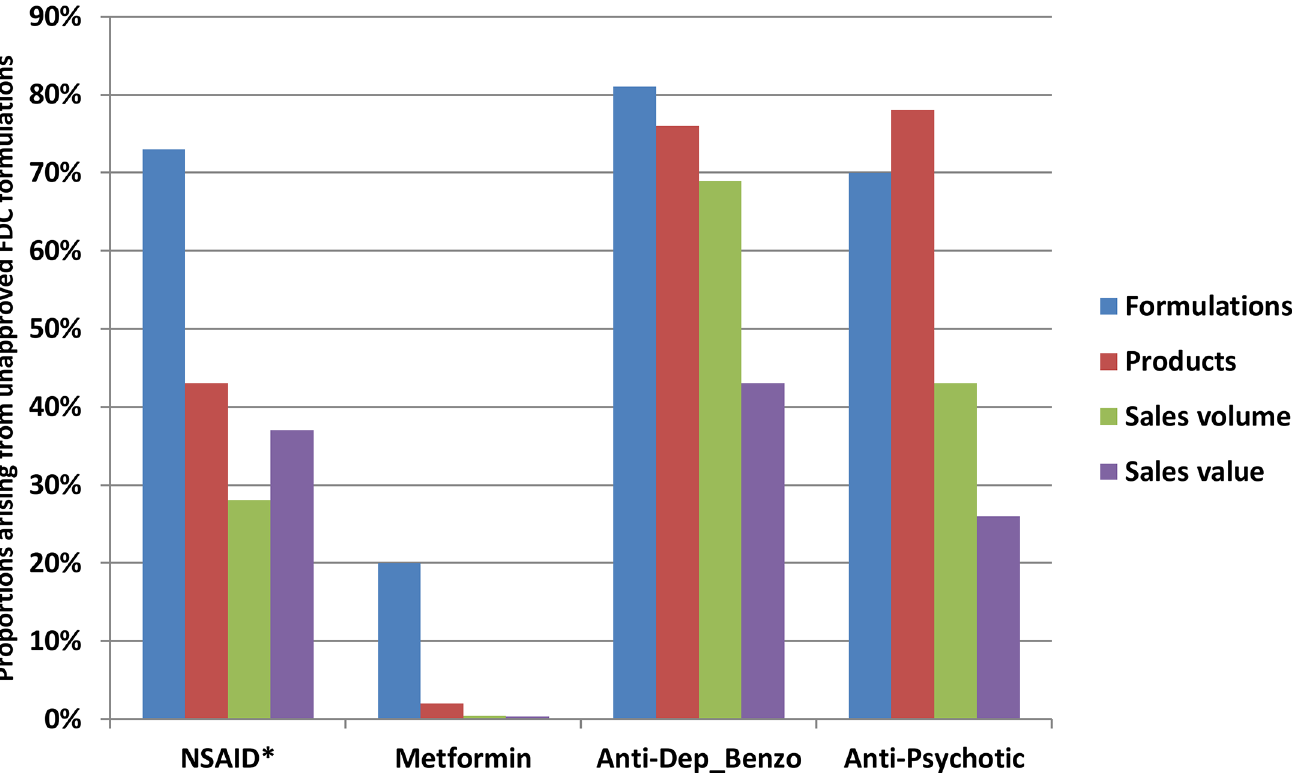
Fig 1. Proportions of formulations on the market, products on the market, sales volume, and sales value in each therapeutic area arising from formulations unapproved by the CDSCO. * Excludes “ other ” formulations.